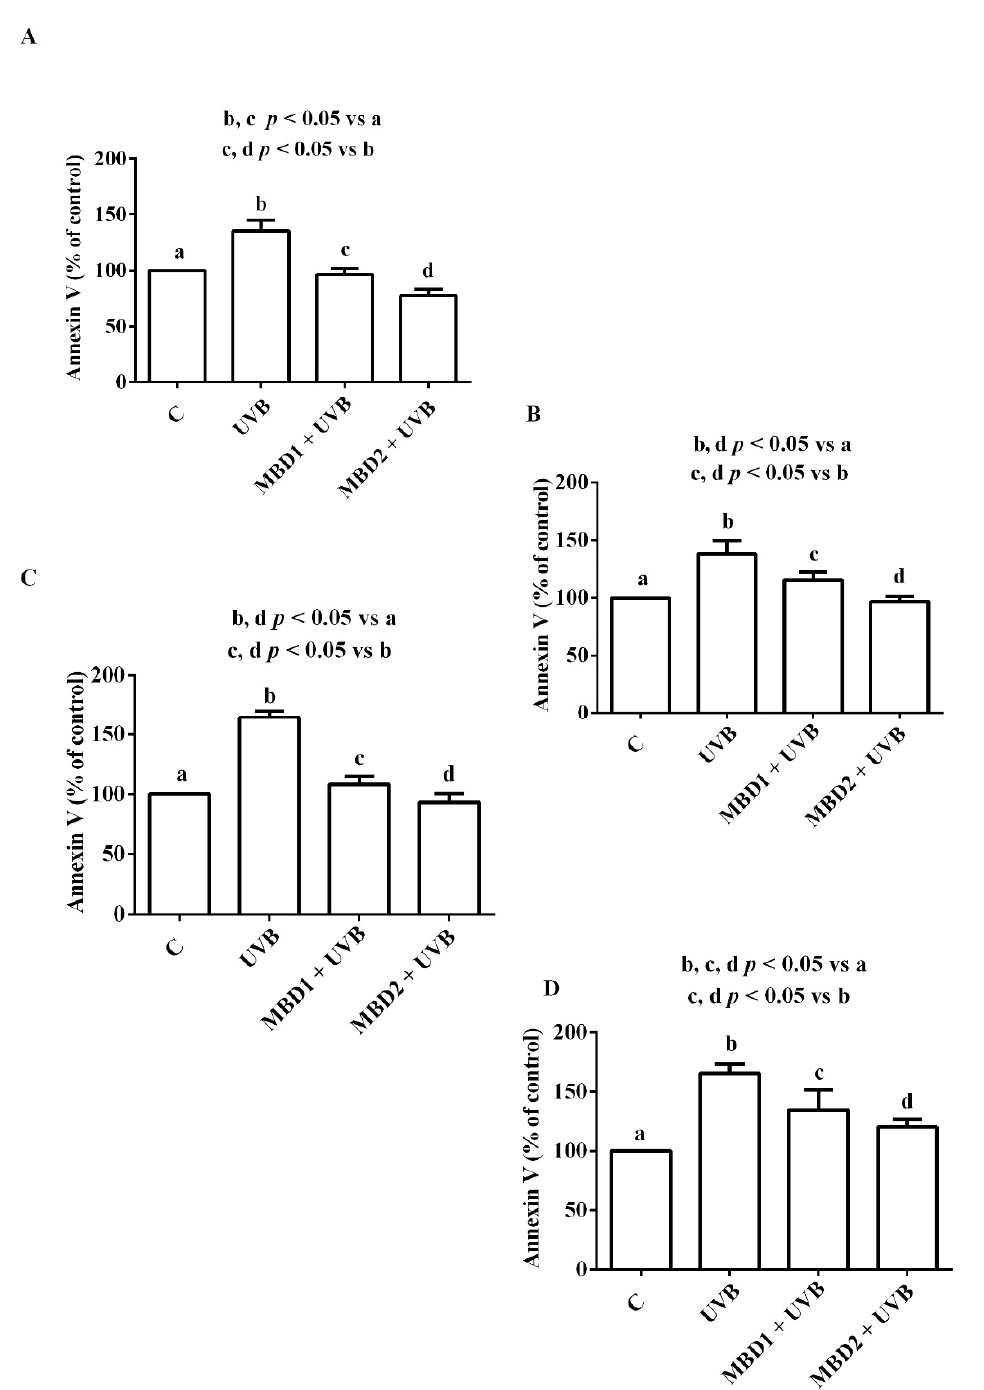
Figure 8. Effects of MBD with ( A , C ) and without PEG ( B , D ) on apoptosis in ARPE-19 cells ( A , B ) and RGC-5 cells ( C , D ). MBD1: MBD at 3 × 10 − 5 M. MBD2: MBD at 7.8 × 10 − 4 M. UVB at 0.117 J/cm 2 for 30 min). The results are means ± SD of repeated experiments. C: control cells (non-treated).